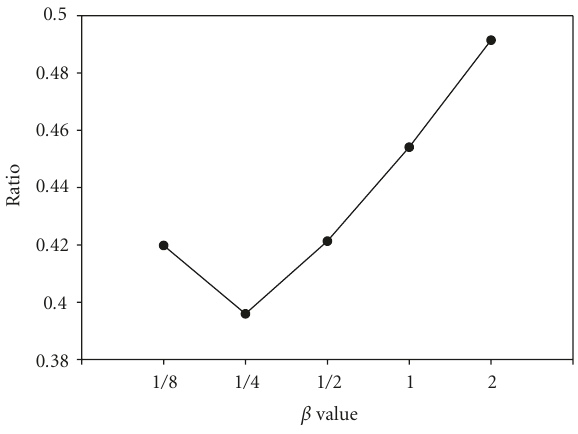
Figure 13: β and ratio.